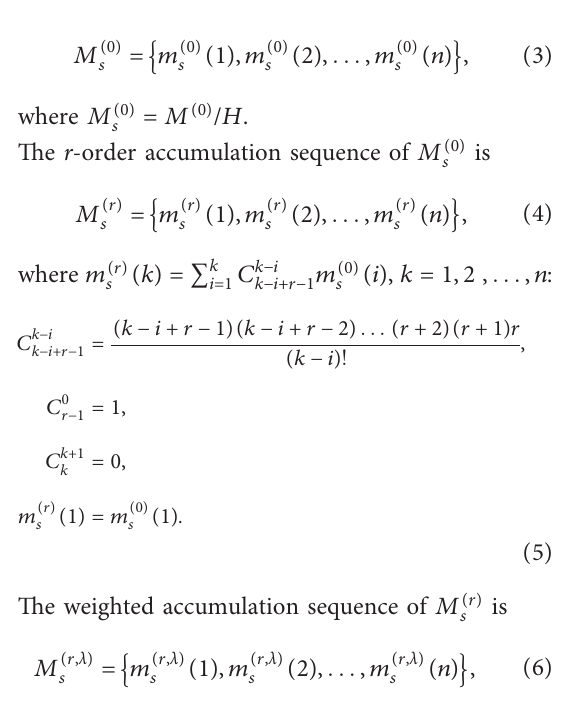
� M ( 0 ) / H . where M ( 0 ) s The r -order accumulation sequence of M ( 0 )